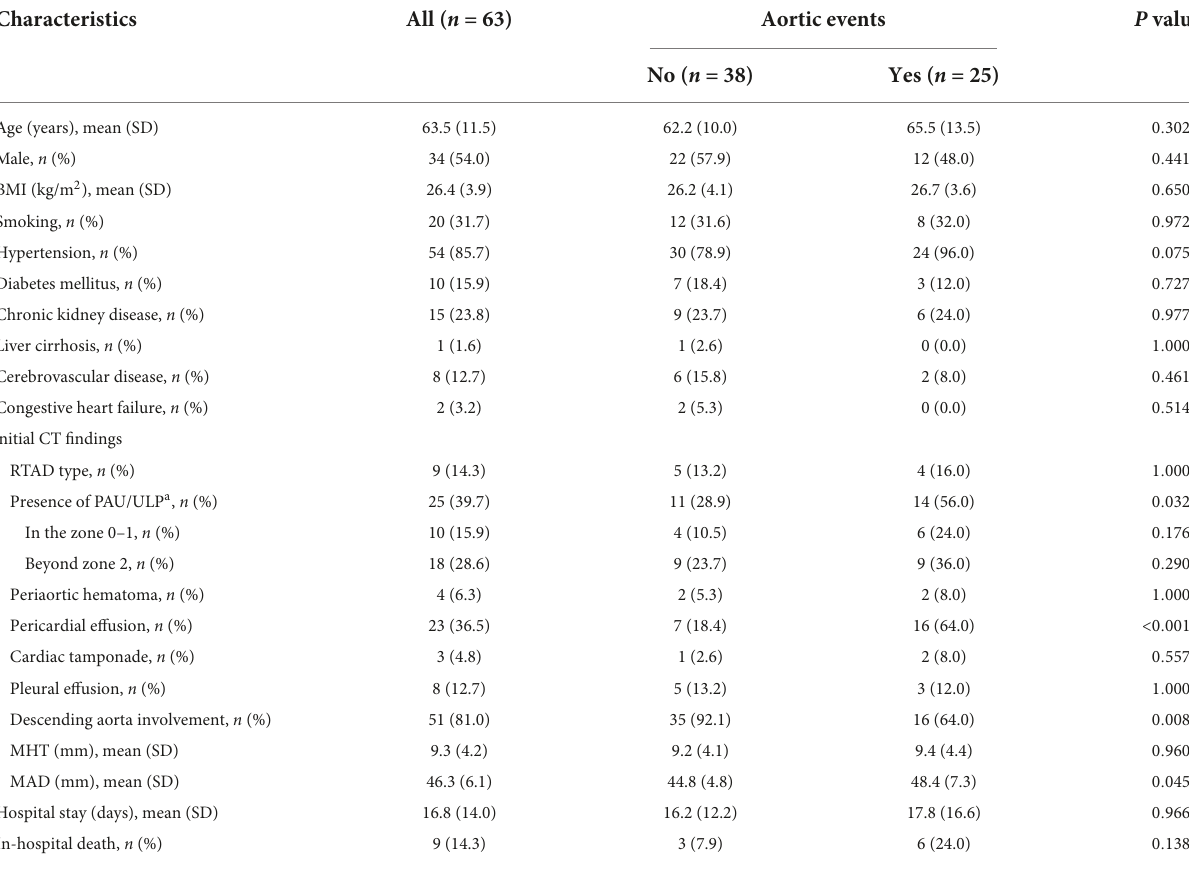
TABLE 1 Baseline demographics and clinical outcomes of